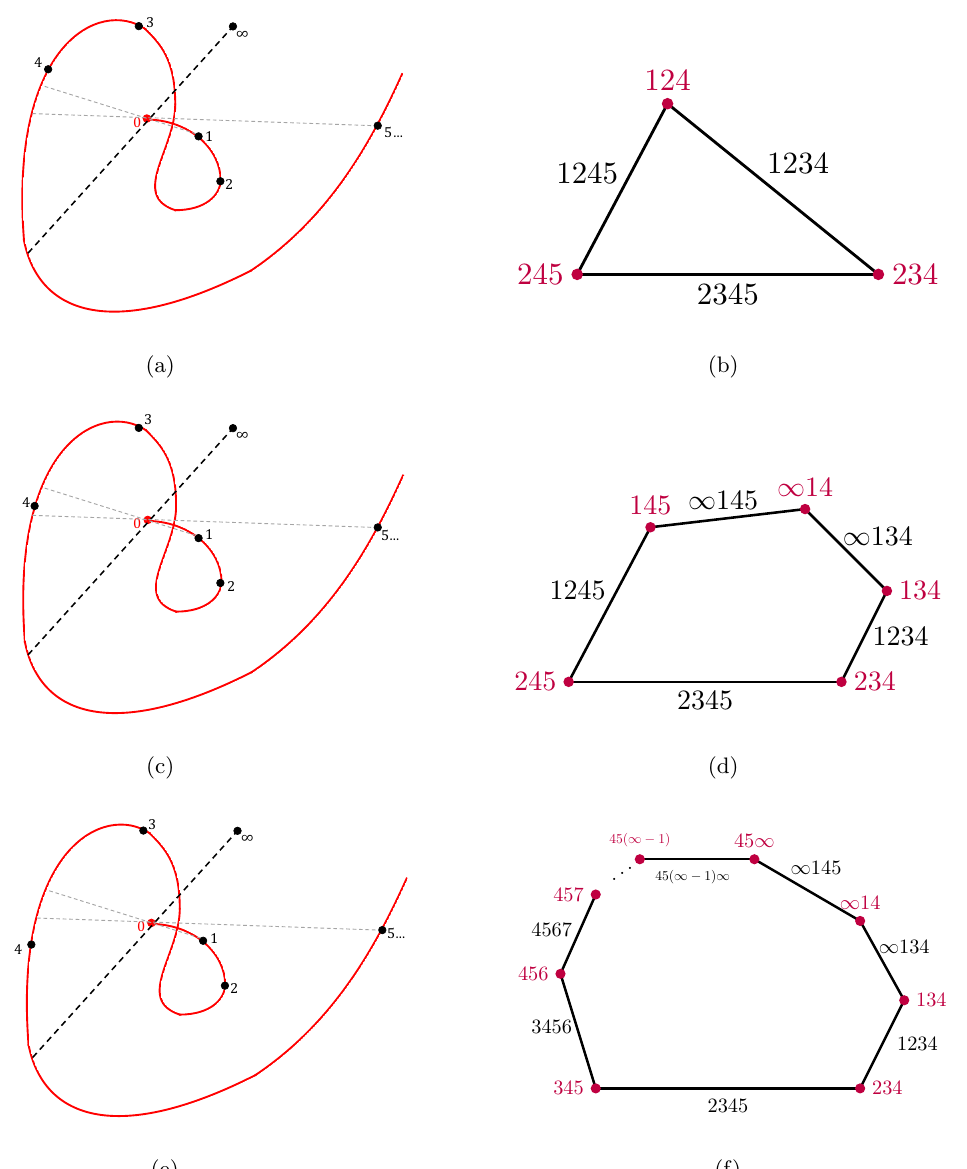
Figure 19 . An illustration of how the polygon on the crossing plane changes its shape as we deform the spectrum. Left: the polytope projected through the crossing plane and the identity 0 as discussed in section 8.1. The references vectors v i ’s are chosen as before. Right: the polygon from the polytope projected onto the crossing plane X , parametrized by F 2 =F 0 and F 4 =F 0